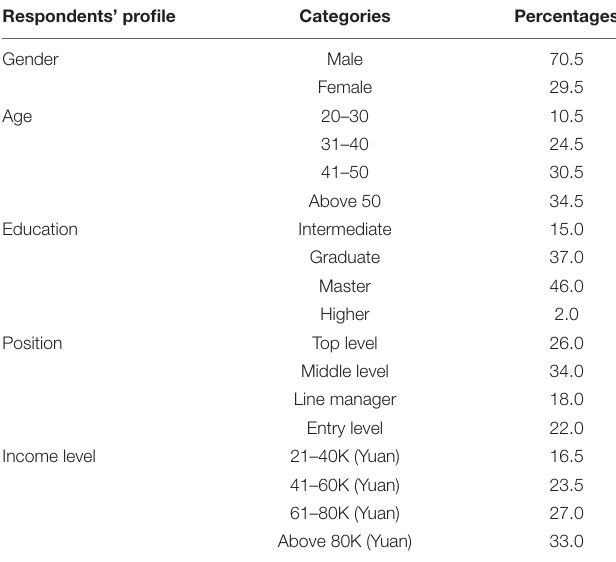
TABLE 1 | Demographics of respondents ( N = 198). TABLE 2 | Internal consistency, convergent validity, composite reliability, and